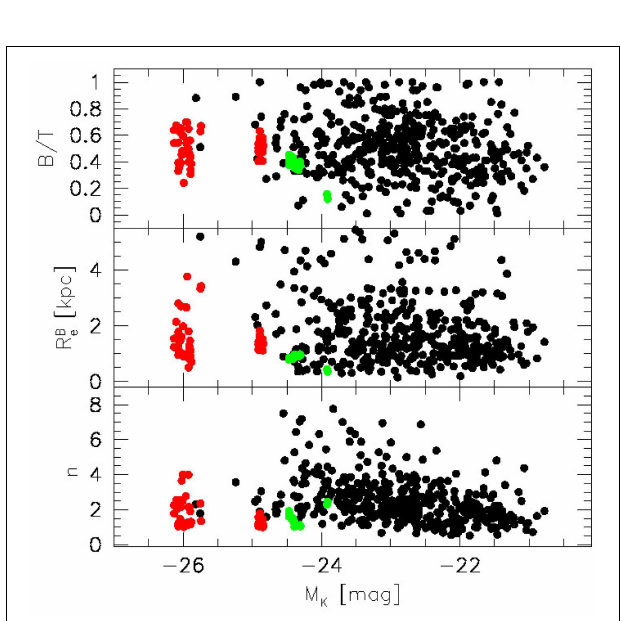
FIGURE 15 | The bulge-to-total luminosity ratio B/T, the effective radius of the bulge, and the Sérsic index of the WINGS S0 galaxies are plotted here vs. the K-band absolute magnitude. The red and green dots mark the bulge-to-disc decomposition of the merging products coming from N-body simulations of Querejeta et al. (2015a) and Tapia et al. (2014), respectively.